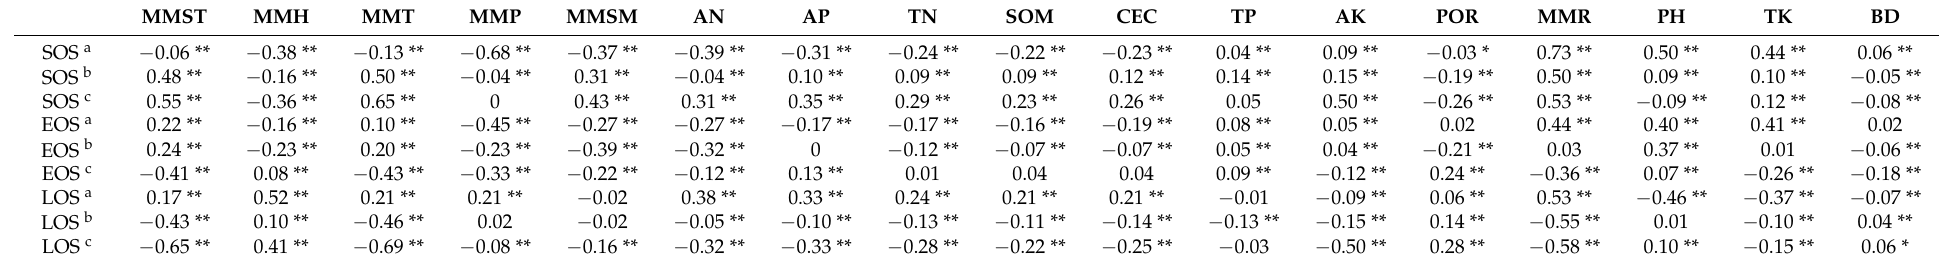
Table 1. The relationships between plant phenology and the principal climate factors along with soil physical and chemical factors at different stages (SOS, EOS, and LOS) in the Yangtze River Basin, Yellow River Basin, and Lancang River